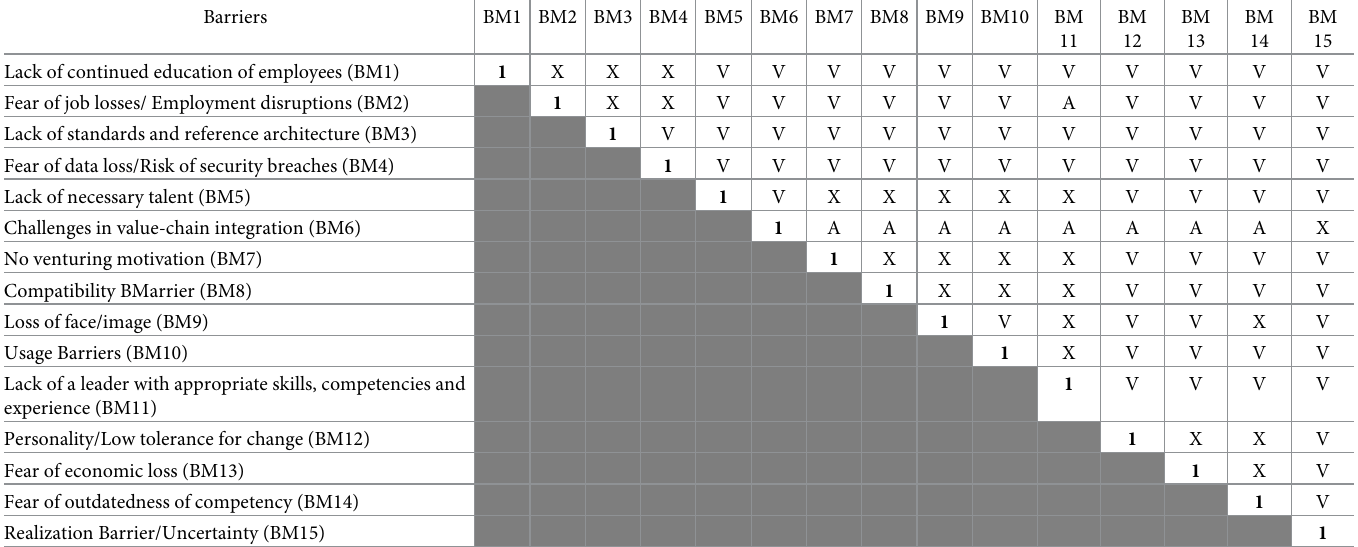
Table 6. Structural self-interaction